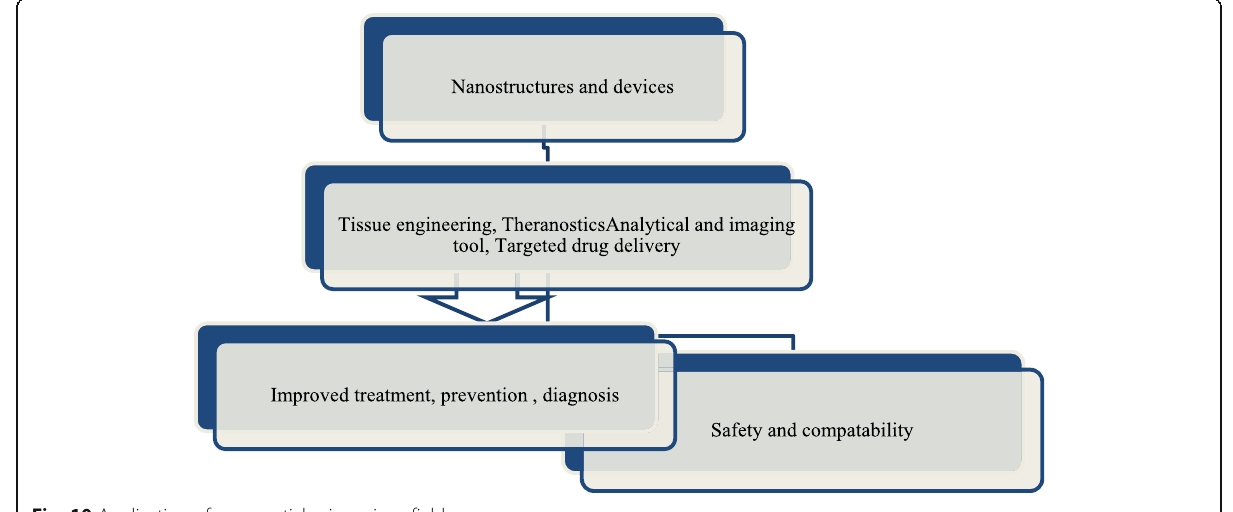
Fig. 10 Application of nanoparticles in various